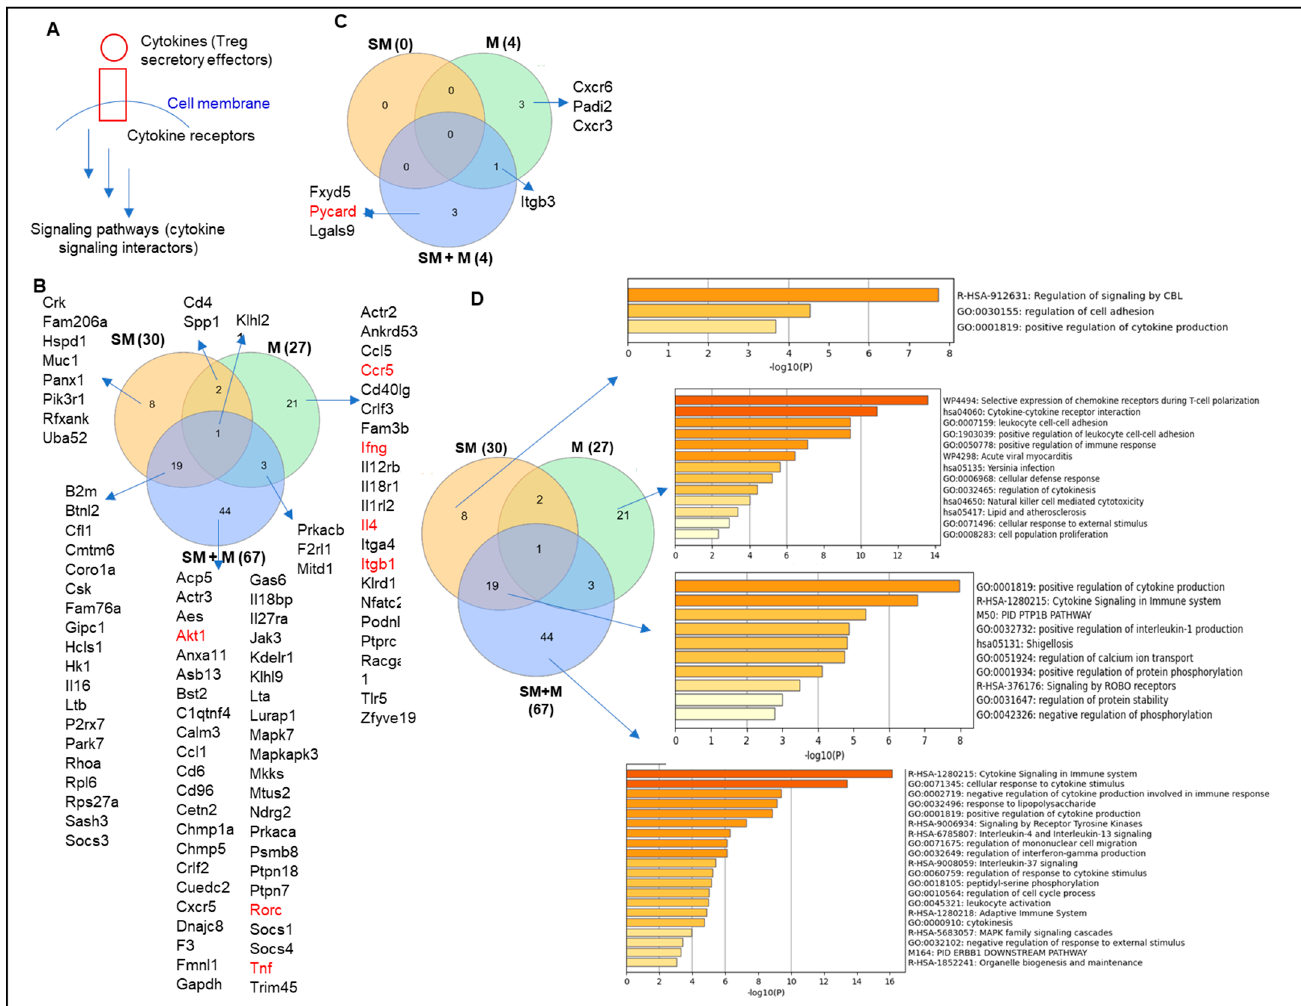
Figure 2. T helper cell 17 (Th17)-specific transcription factor RORC and proinflammatory cytokine TNF are upregulated in Tregs from the cigarette smoke plus morphine (SM + M)-treated